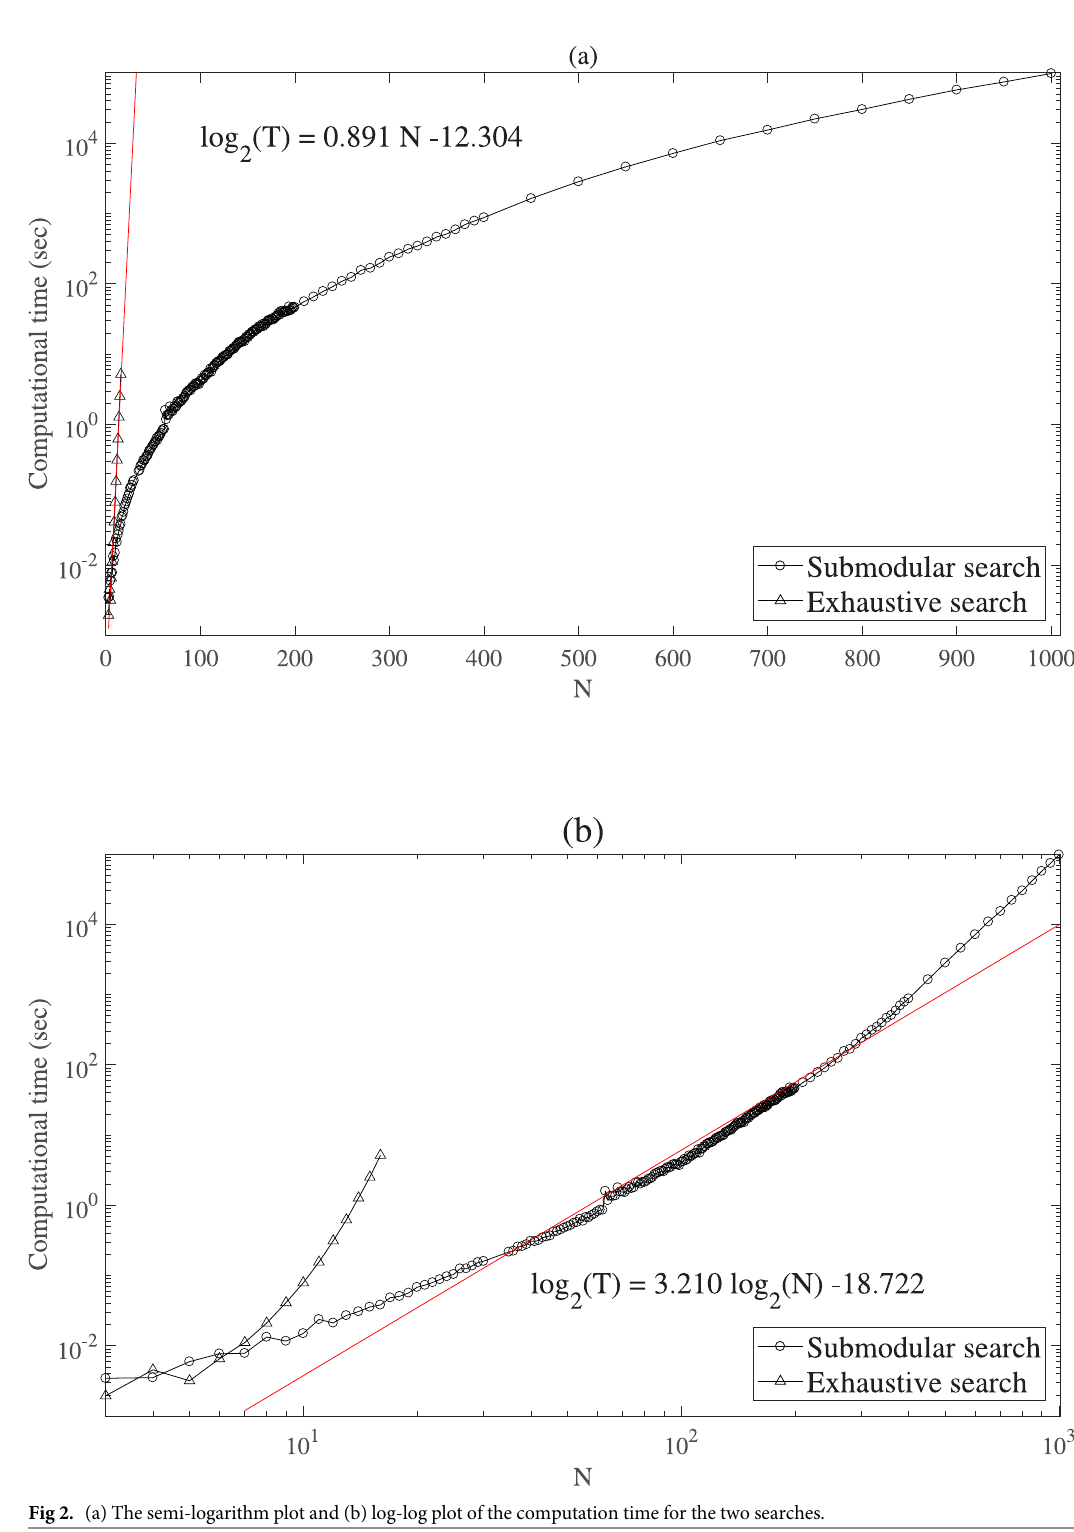
PLOS ONE | https://doi.org/10.1371/journal.pone.0201126 September 11,